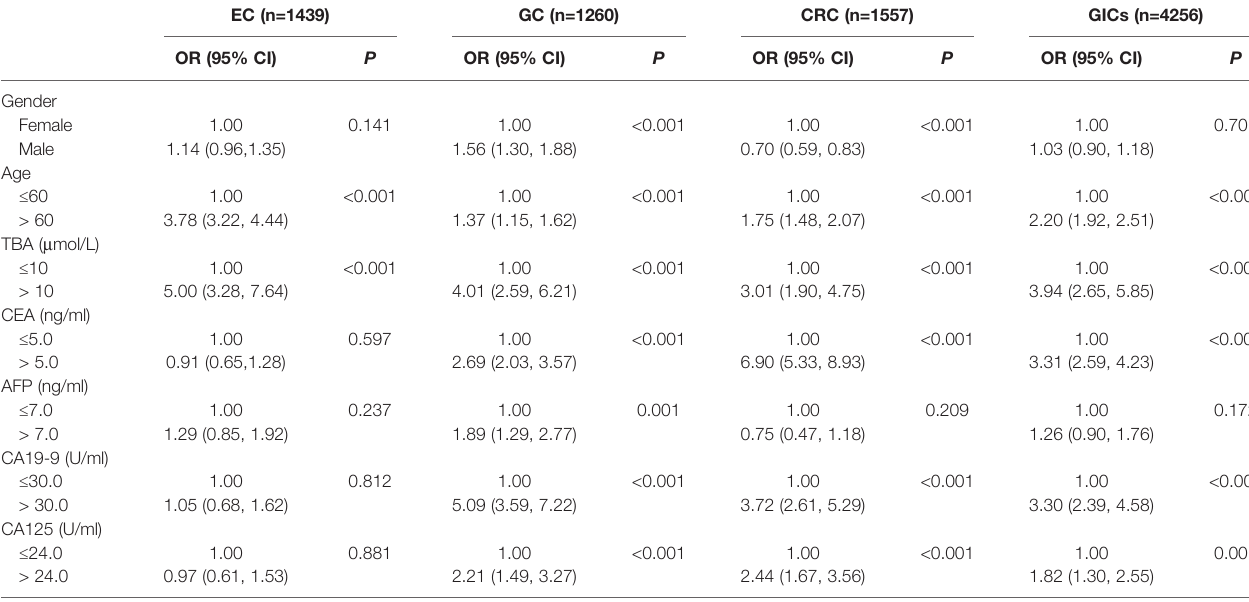
TABLE 3 | ORs and 95% CIs for GICs in association with patients ’ demographic, clinical and laboratory data by binary logistic regression (N=5589) a